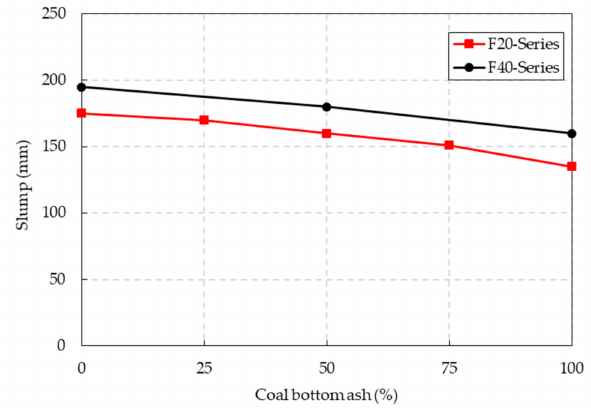
Figure 4. Slump test results of the CBA